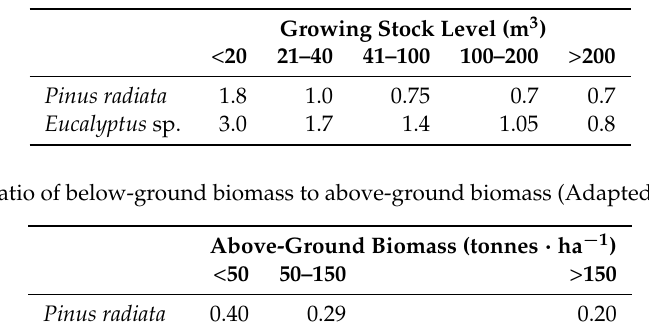
Table 1. Biomass conversion and expansion factors (BCEF) of merchantable growing stock volume to above-ground biomass (Adapted from [17]).